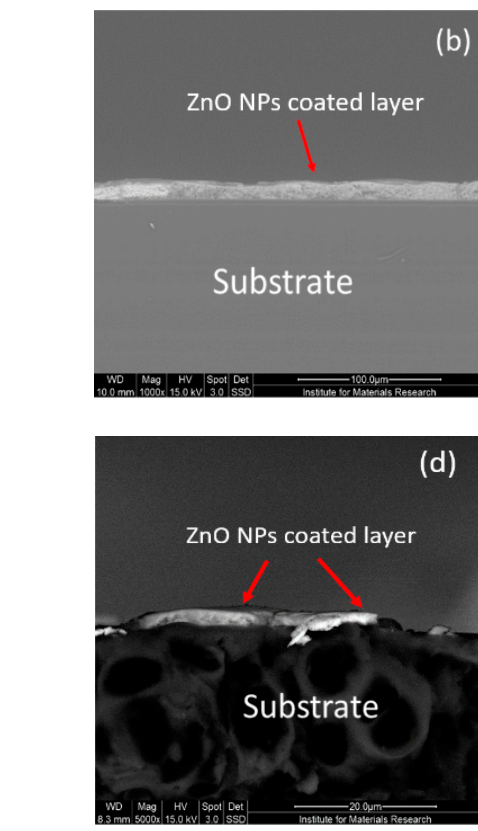
Figure 4. ( a ) Top-side SEM image of 50× ZnO NP-coated PET substrate; ( b ) cross-sectional SEM image of 50× ZnO NP-coated PET substrate; ( c ) top-side SEM image of 50× ZnO NP-coated PHBHHx substrate; ( d ) cross-sectional SEM image of 50× ZnO NP-coated PHBHHx substrate [48].